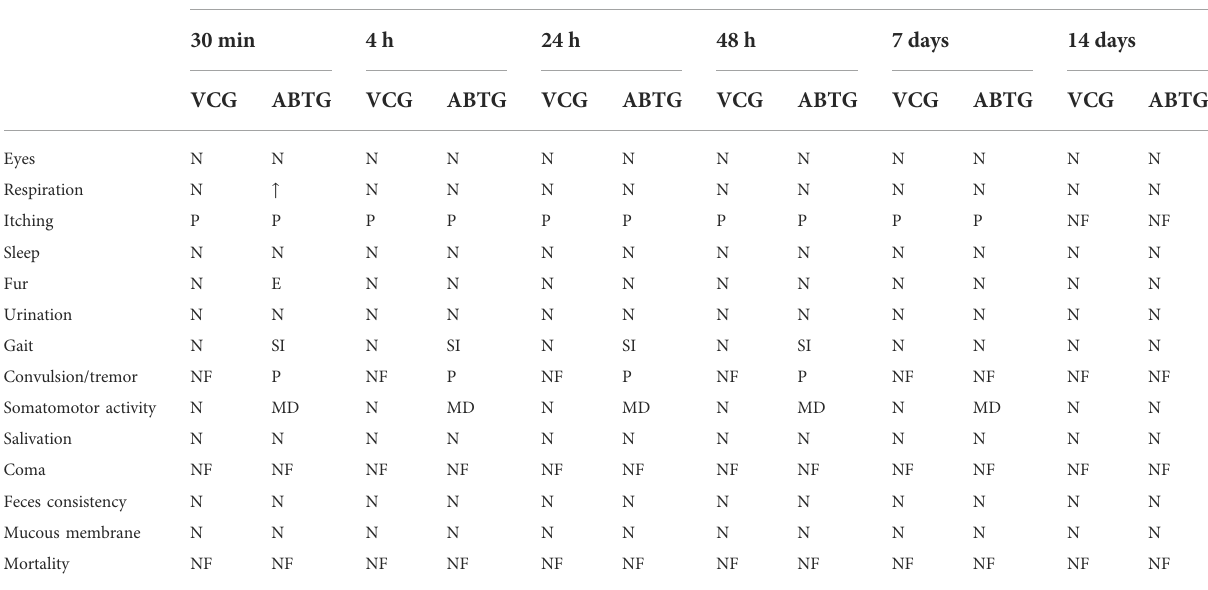
TABLE 2 Behavioral pattern of rats treated with ABEE (2000 mg/kg p.o.) during acute toxicity study. Parameters